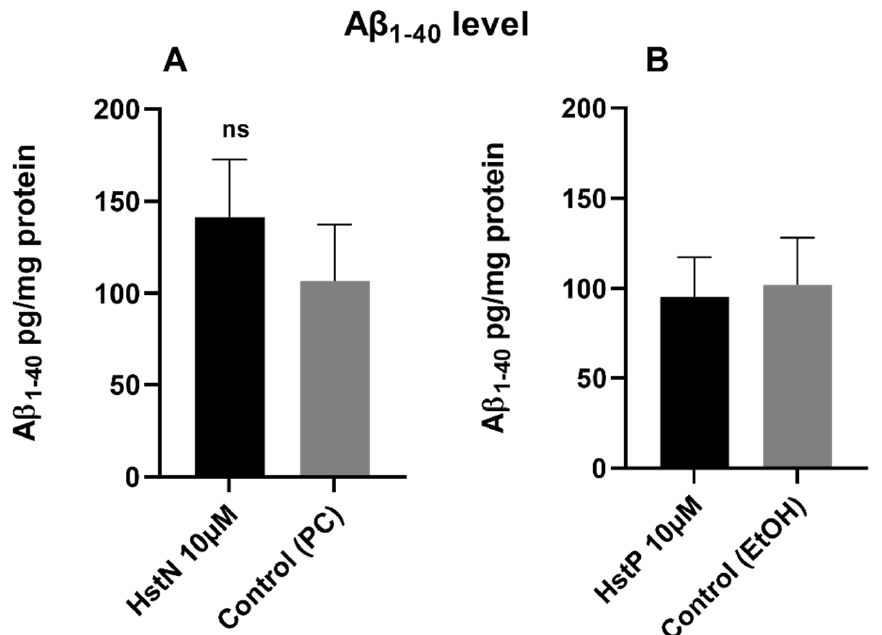
Figure 5. Effect of HstN and HstP on A β 1-40 levels in SH-SY5Y-APP 695 cells. Concentration of A β 1-40 in SH-SY5Y-APP 695 cells: ( A ) incubated for 24 h with HstN, with PC as control, and ( B ) incubated for 24 h with HstP, with ethanol as control. Values are adjusted to protein concentrations. Respective mean values ± SD are shown, N = 6. Significance was determined with unpaired Student’s t-test. ns, not significant; HstN, hesperetin nanocrystal; HstP, hesperetin in pure form; PC, PlantaCare; EtOH, ethanol .